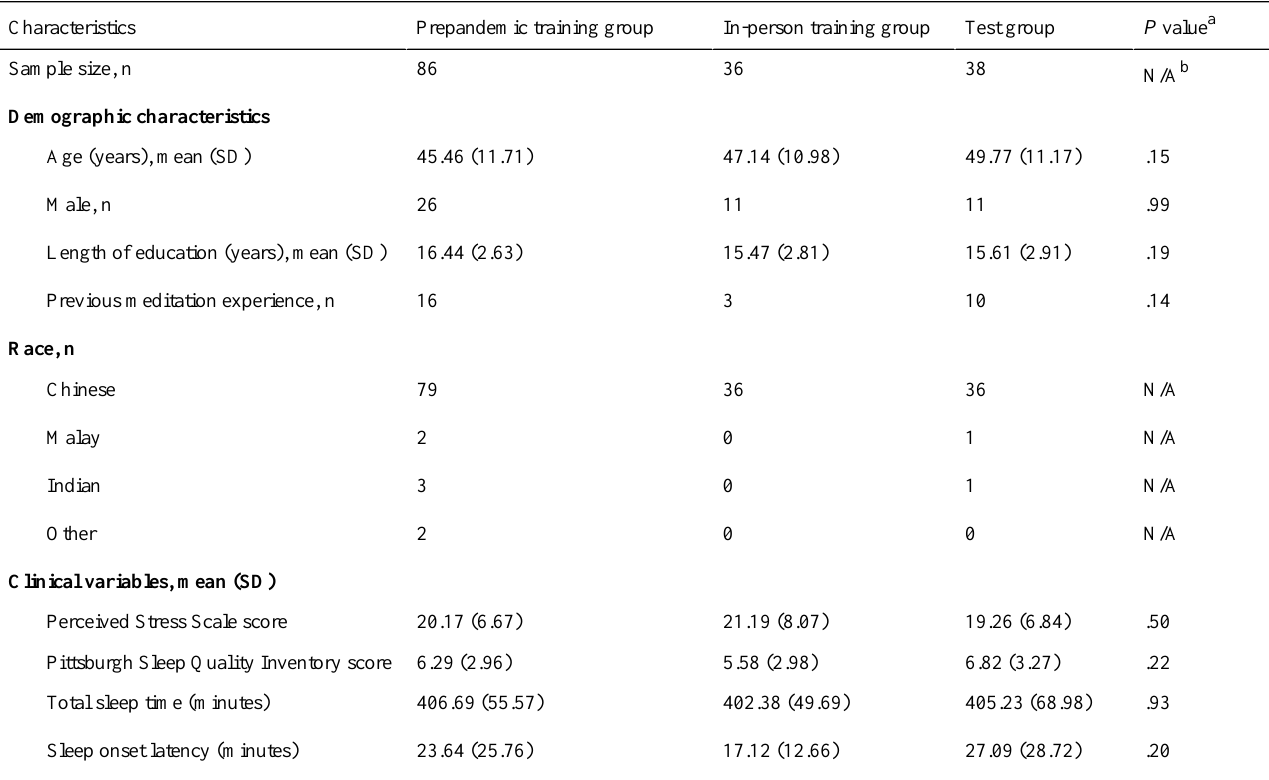
Table 1. Participants’baseline